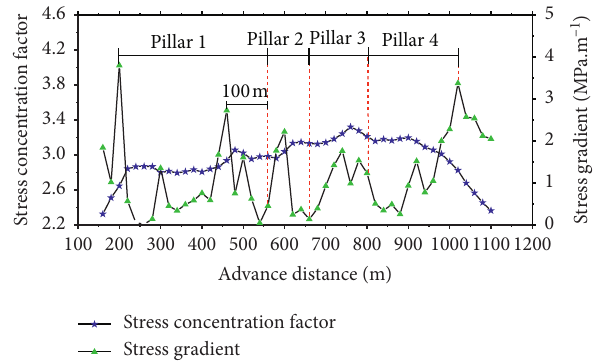
Figure 9: Varying curve of vertical stress in different mining